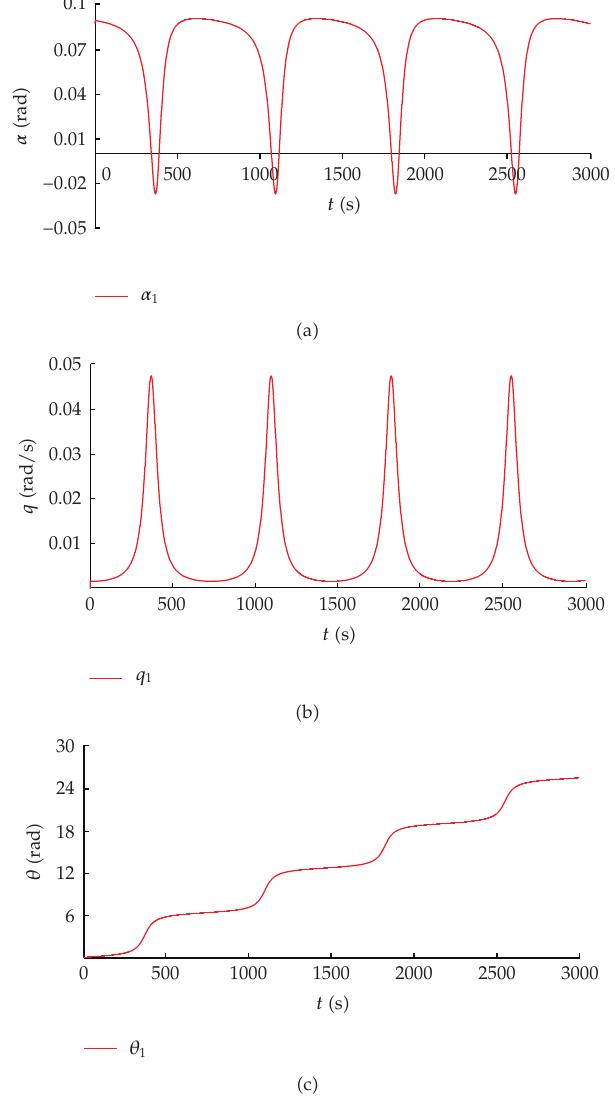
(cid:7) − 0 . 04678 (cid:5) rad (cid:6) (cid:7) − 2 . 681 ◦ → δ (cid:6)(cid:6) (cid:7) − 0 . 05 (cid:5) rad (cid:6) (cid:7) − 2 . 866 ◦ and the starting e e (cid:7) 0 (cid:5) rad / sec (cid:6) ; θ (cid:6) (cid:7) 0 . 159329 (cid:5) rad (cid:6) (cid:7) 9 . 133 ◦ 1 1